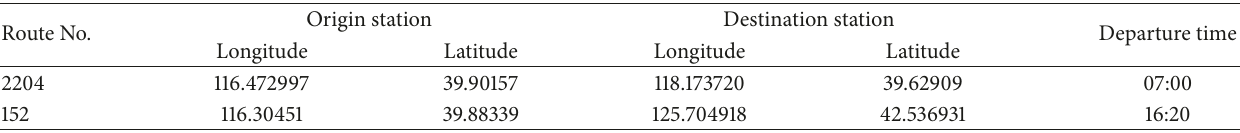
Table 2: Sample of basic coach route information.